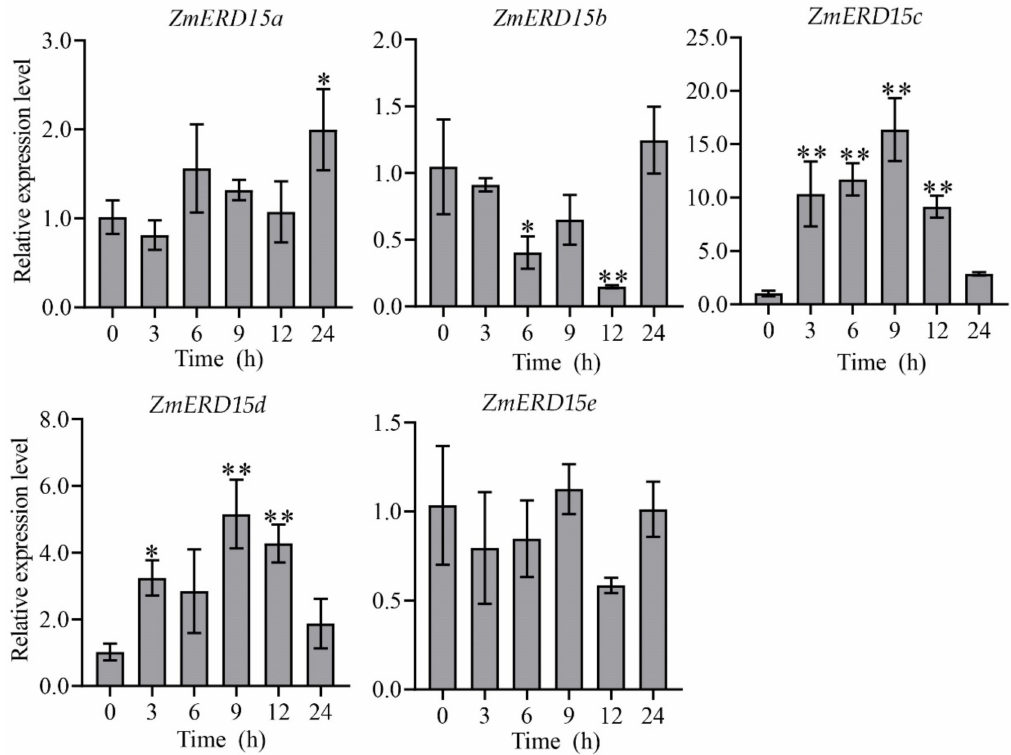
Figure 7. Expression of ZmERD15s in response to 100 µ M ABA. * and ** indicate significant differences from the level of expression at time 0 at p < 0.05 and p < 0.01, respectively.